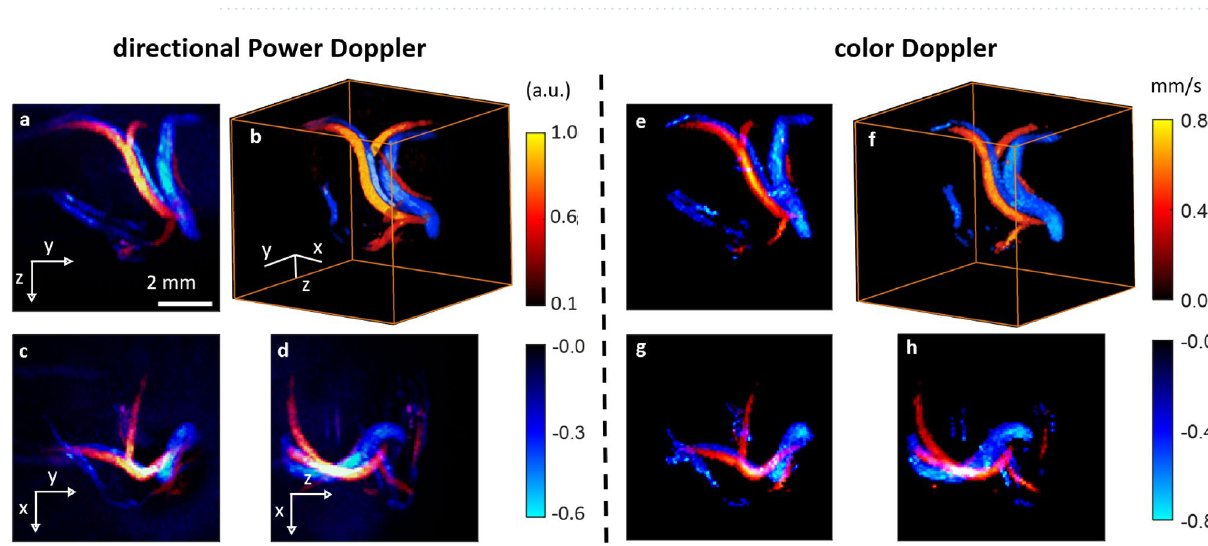
Figure 5. Flow dynamics in chicken embryo by ultrasound Directional Power Doppler (US-dPwD) and Color Doppler (US-CoD). Left panel ( a–d ) US-dPwD (red: upward flow, blue: downward flow). Right panel ( e–h ) US-CoD. (red: upward flow, blue: downward flow). 2D images are maximum intensity projections through the 3D